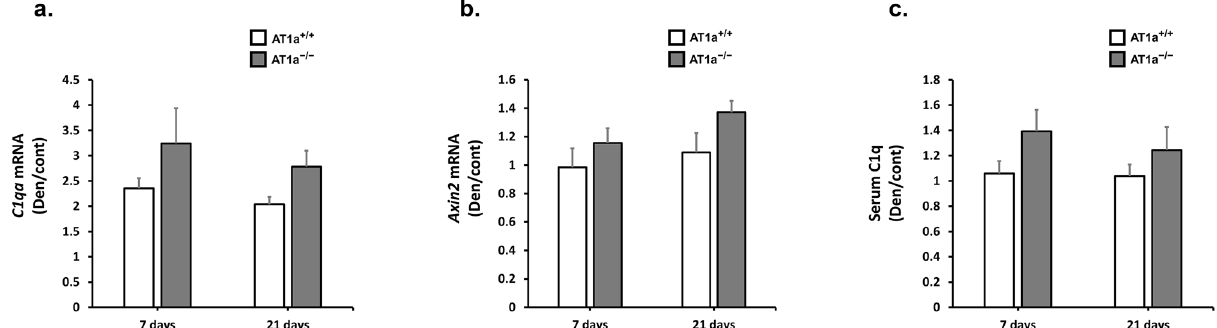
Figure 5. AT1a receptor loss alleviated denervation-induced muscle atrophy independently of C1q/Wnt/β- catenin signaling in gastrocnemius muscle. ( a , b ) Gene expressions of C1qa ( a ) and Axin2 ( b ) were evaluated by RT-qPCR. Expression levels of these transcripts in each sample were normalized to 18S rRNA expression levels and were shown as the fold increase or decrease in mRNA expression in the Den group compared with the Cont group. ( c ) Serum C1q concentration was measured by ELISA. The graphs show the fold increase or decrease in serum concentration levels in the Den group compared with the Cont group. AT1a +/+ -Cont group, n = 6; AT1a +/+ -Den group at 7 days postdenervation, n = 7; AT1a +/+ -Den group at 21 days postdenervation, n = 7; AT1a −/− -Cont group, n = 5; AT1a −/− -Den group at 7 days postdenervation, n = 6; AT1a −/− -Den group at 21 days postdenervation, n = 6. Values are means ± SE.